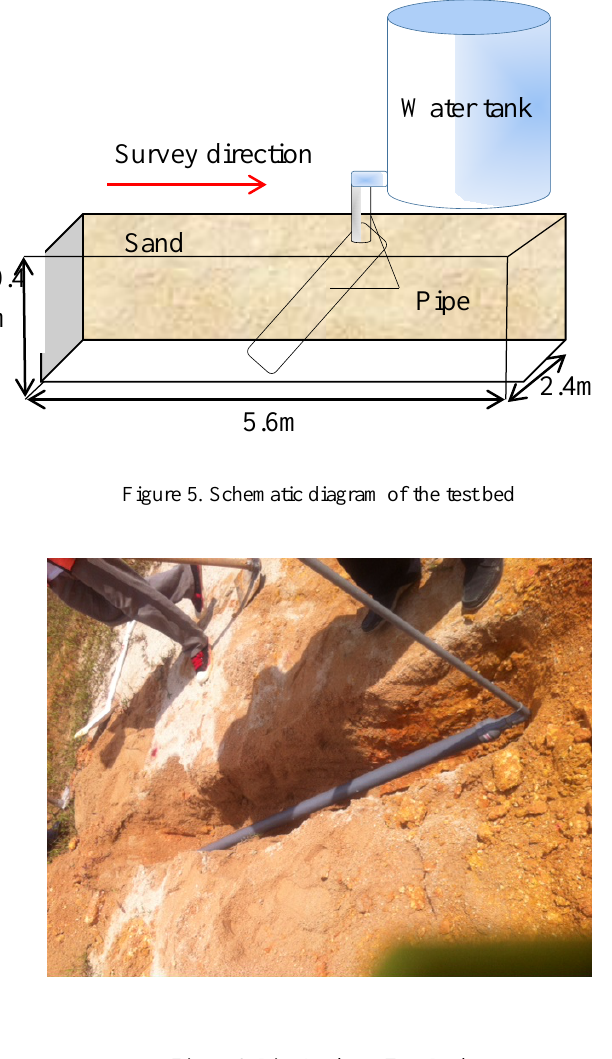
Figure 6 . Pipe Leakage Test Bed